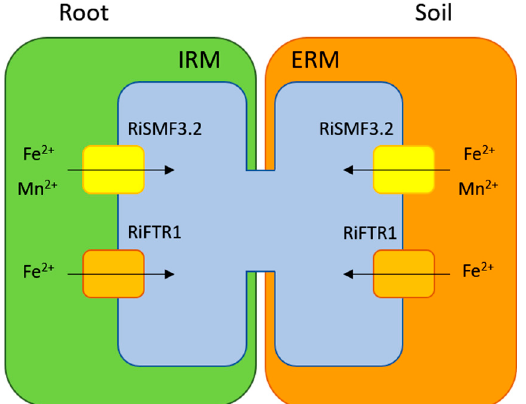
Figure 9. Schematic diagram of the Mn and Fe uptake systems in the ERM and IRM of the AM fungus R. irregularis .